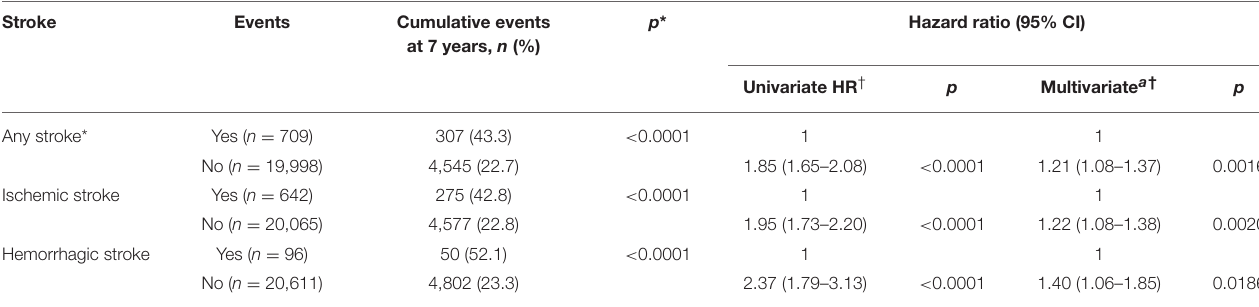
TABLE 4 | Effects of stroke on survival in patients with